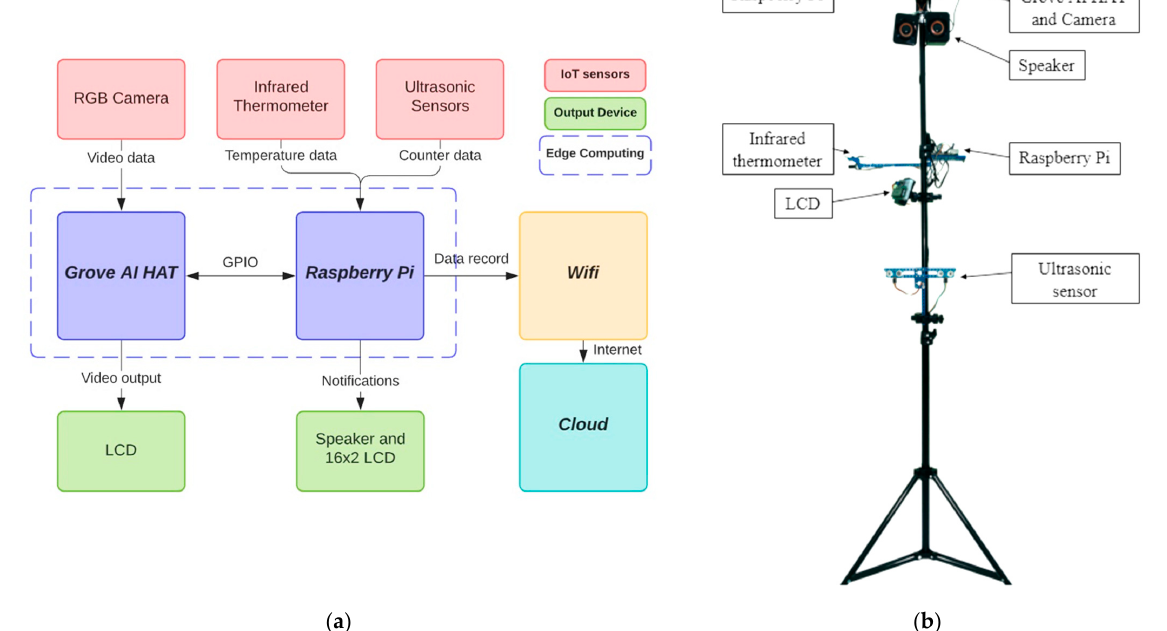
Figure 2. ( a ) Block diagram of PADDIE-C19 system and ( b ) PADDIE-C19 system prototype.